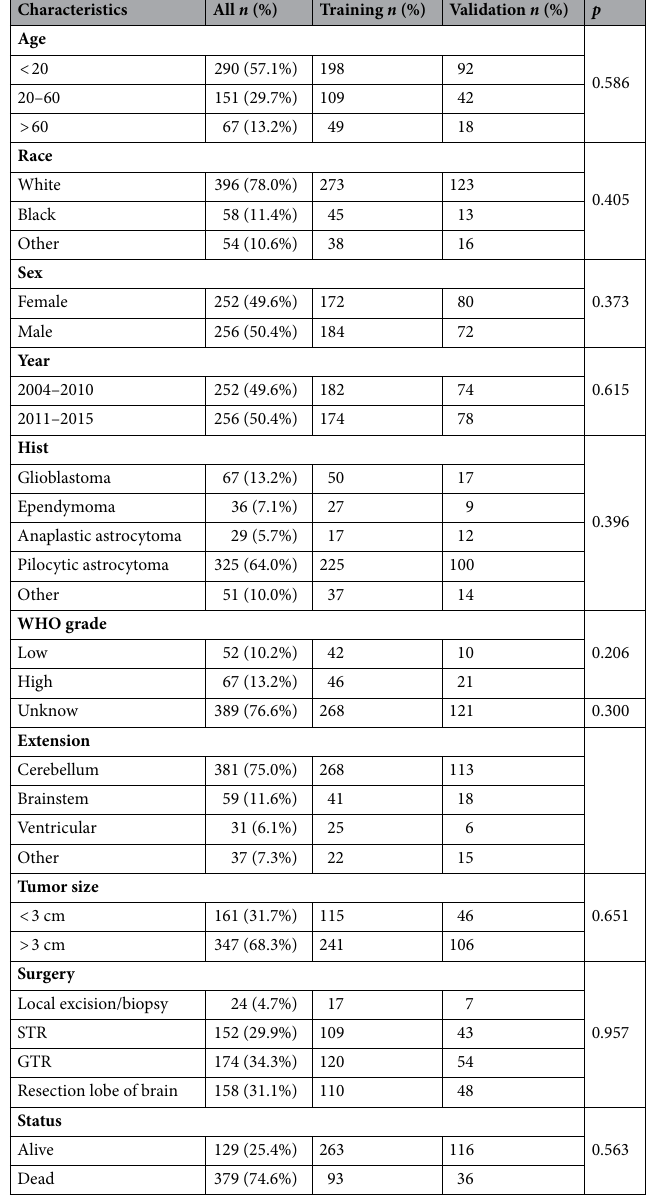
Table 3. Training and validation of cerebellum glioma